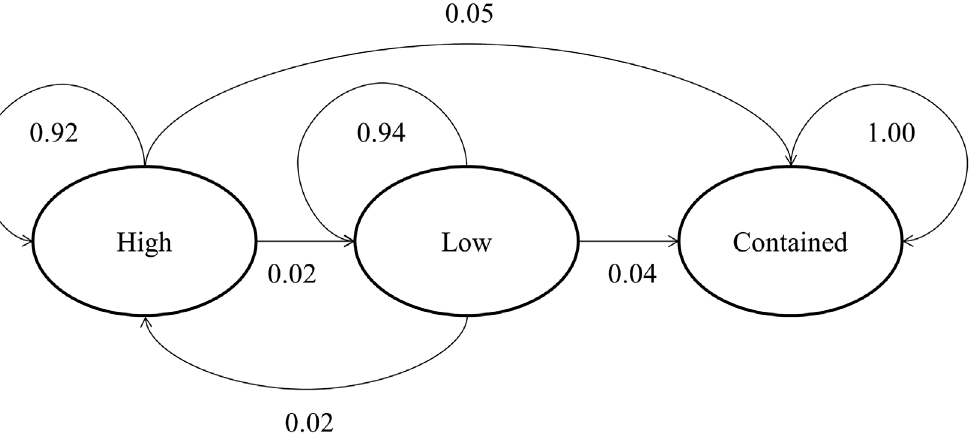
Figure 4. Three-state Markov Chain model of national-scale incident complexity dynamics, a simplified representation of the results presented in Table 3. Due to rounding the presented transition probabilities may not sum perfectly to 1.00.